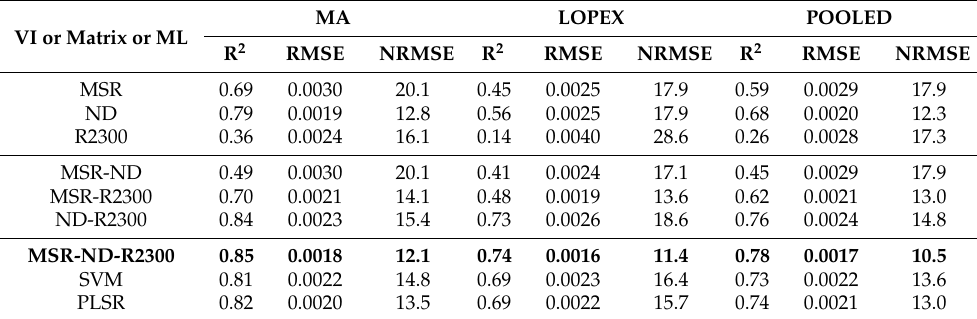
Table 6. Corresponding to the MSR-ND-R2300 matrix, the coefficient of determination (R 2 ), root mean square error (RMSE, in g/cm 2 ), and normalized RMSE (NRMSE, %) of the estimated LMA from experimental datasets using the 3D matrix, corresponding 2D matrices, single VIs, support vector machine (SVM), and partial least-squares regression (PLSR) (the optimal results are indicated in bold). MA LOPEX